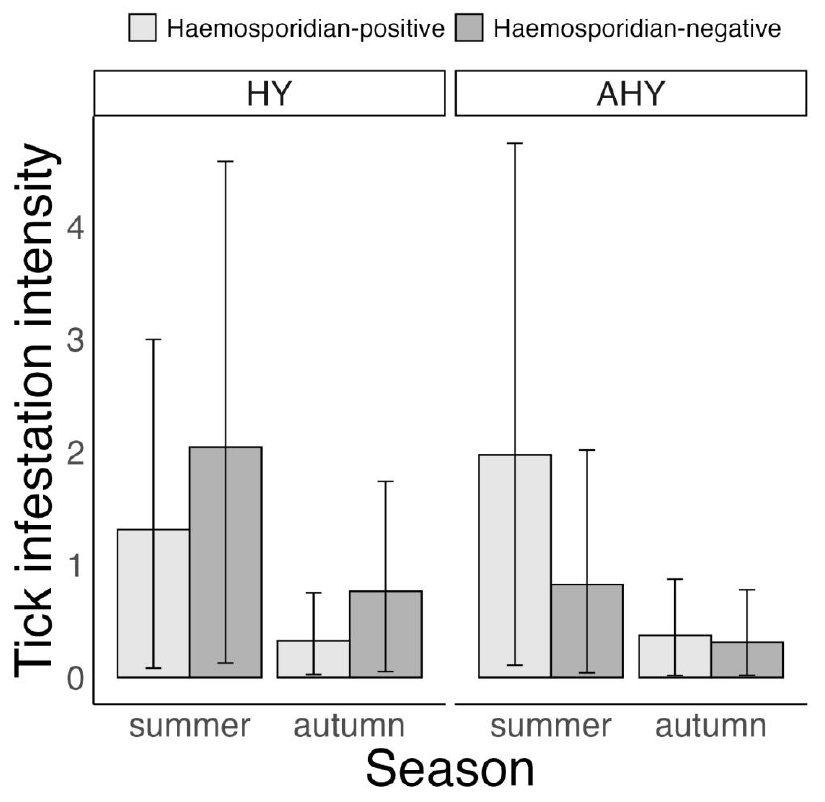
Figure 3. Bayesian zero inflated negative binomial model on variation in Ixodes ricinus tick infestation intensity according to haemosporidian infection status and age of six avian host species in Slovakia, 2017–2019. Displayed are posterior means and 95% CrI. Host age was classified as hatch-year (HY) and after-hatch-year (AHY). Note that spring was not considered in the model because only AHY birds were captured at that time of